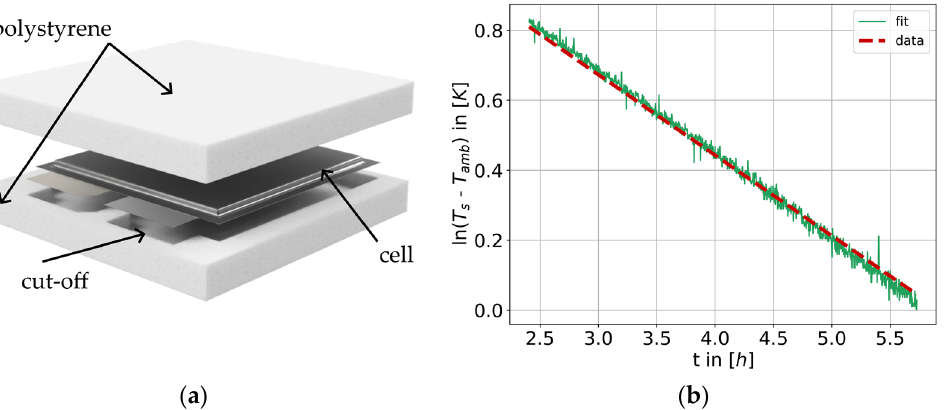
Figure 6. Reference testing scheme. ( a ) Depiction of the used setup; ( b ) resulting temperature dif ‐ ference of the cell on a logarithmic scale, showing both measured and fitted data. difference of the cell on a logarithmic scale, showing both measured and fitted